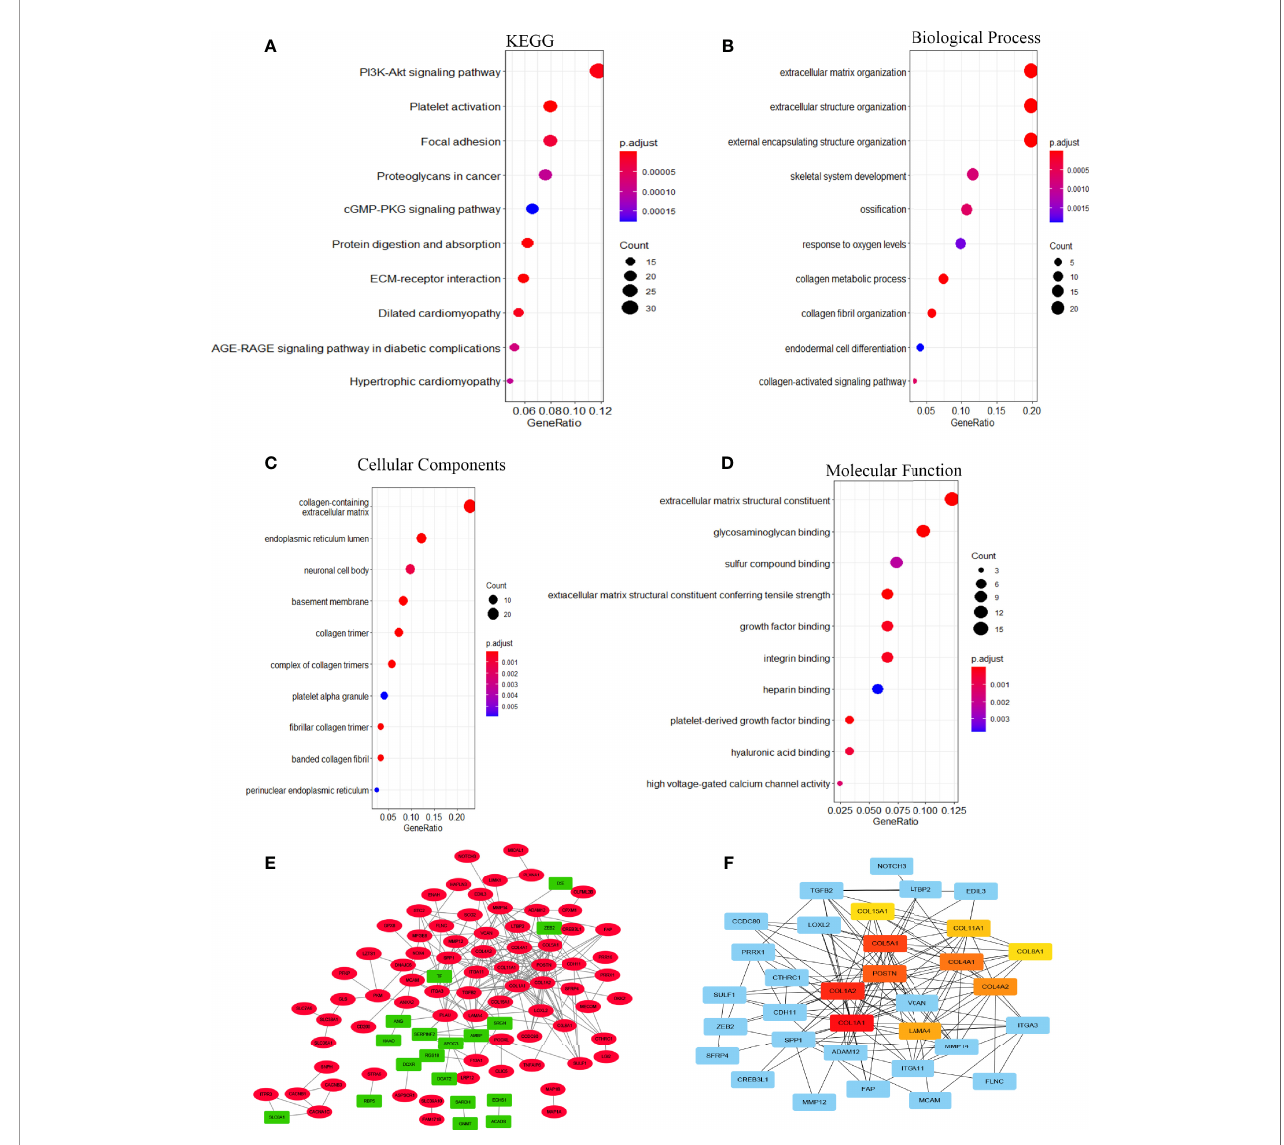
FIGURE 5 | The function network of ERGs. (A) KEGG and (B – D) GO enriched terms were colored according to P -adjust. (E) Construction of gene co-expression networks. Green represented genes that were negatively related to EOGT , and red pointed out genes that were positively related to EOGT . The darker the color, the stronger the correlation. (F) Hub genes of the PPI network; the darker the color, the bigger the